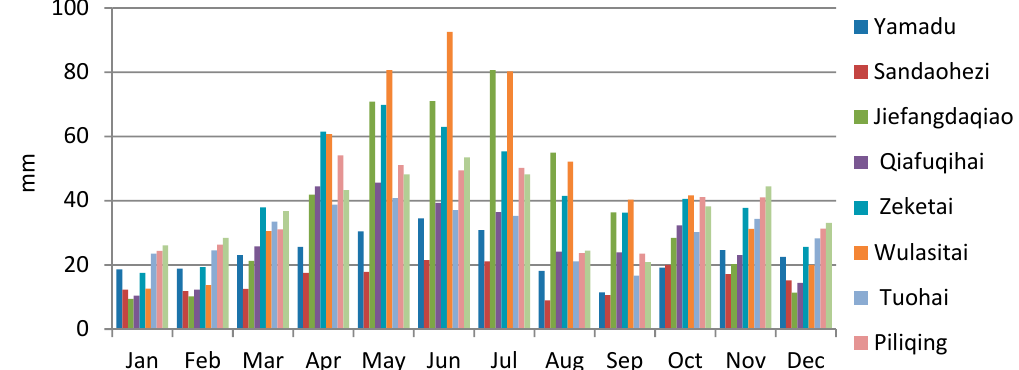
Figure 2. Annual cycle of precipitation in the research area for the selected meteorological stations. Locations of the stations is shown in Figure 1. Table 1. Hydrometeorological stations in the Chinese sector of the Ile River Basin (C-IRB). Locations of the stations are shown in Figure 1.